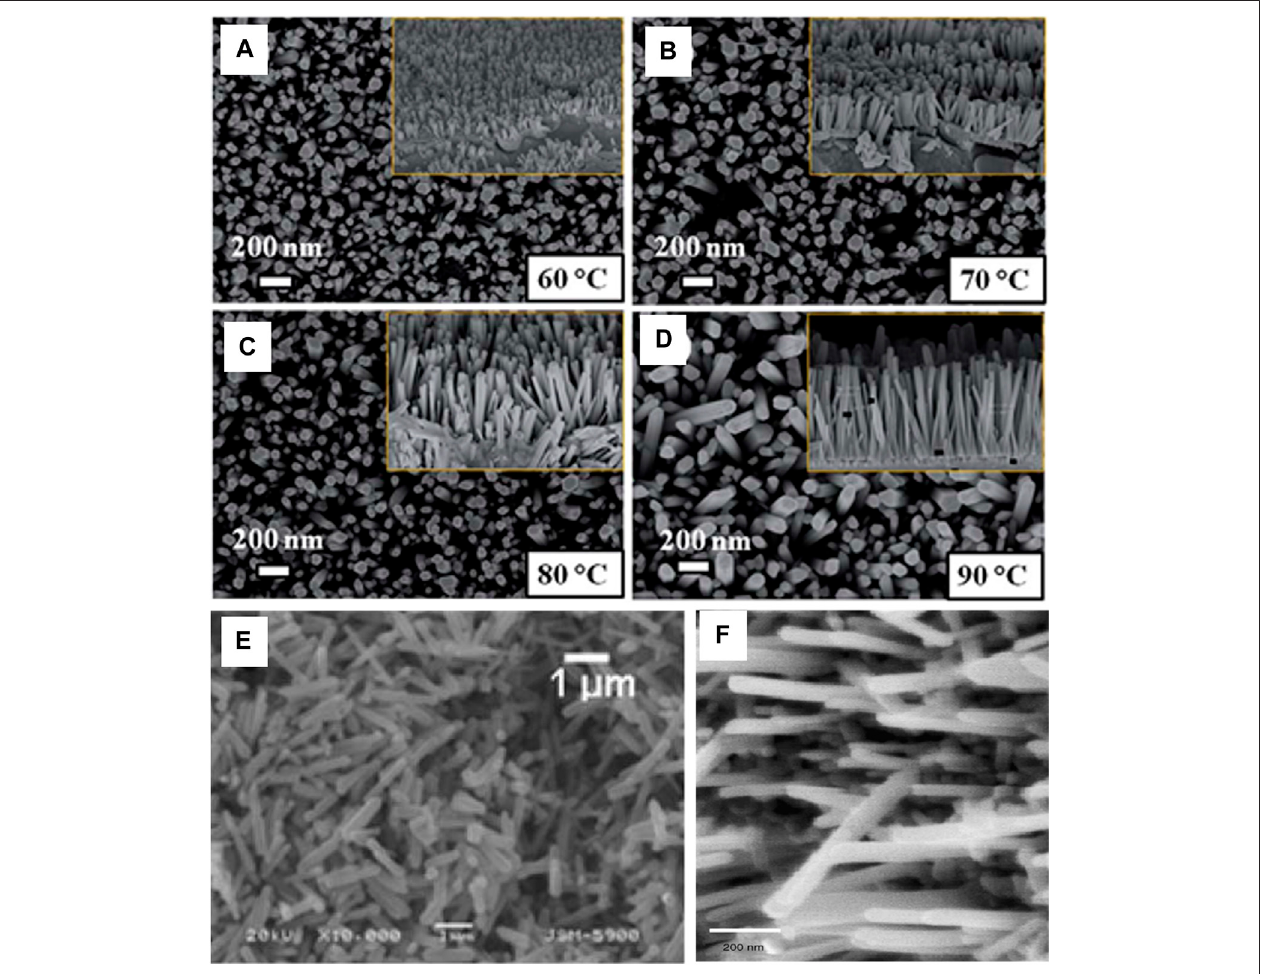
FIGURE 5 | FE-SEM images for the as-grown ZnO nanorods at different growth temperatures of (A) 60 ° C, (B) 70 ° C, (C) 80 ° C, (D) 90 ° C (Note: inset fi gures show thecorrespondingcrosssectionalimages)(Gaddam etal.,2015).; (E) SEMimages ofZnOpreparedinthepresenceofCTAB (Rai etal.,2009) (F) SEMimage oftheZnO nanorods (Jiaqiang et al.,